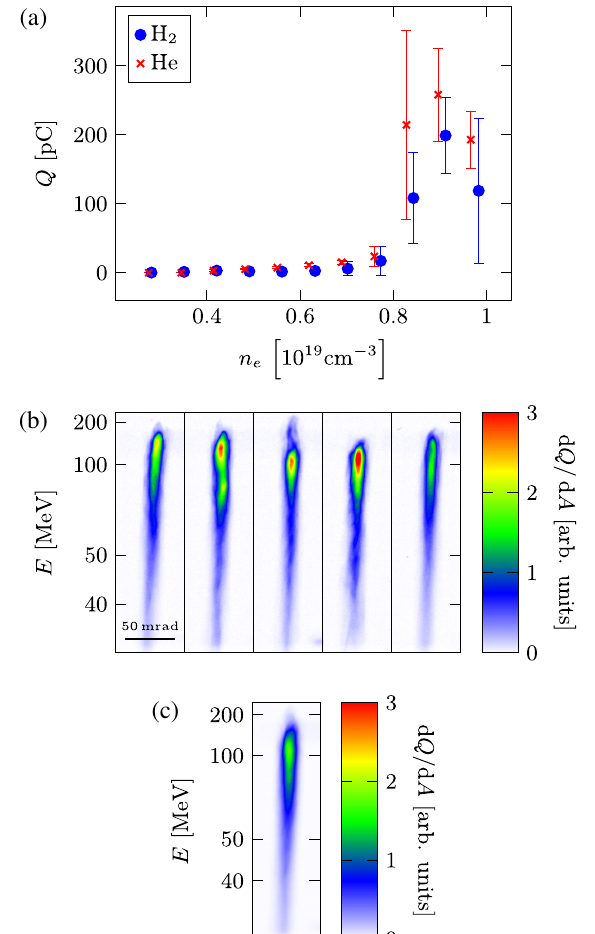
FIG. 4. (a) Measured charge Q from Fig. 2 plotted against plasma electron density n e (assuming full ionization) instead of backing pressure p 0 , by using the results of Fig. 3. Again, only electrons with energies exceeding the cutoff energy of the spectrometer setup contribute to Q . Each point represents the average of ten individual measurements with error bars indicating one standard deviation. (b) False-color images of five electron beams emerging from He at n e ¼ 9 . 8 × 10 18 cm − 3 dispersed by a permanent dipole magnet, showing a high resemblance to electron beams accelerated in H 2 at similar n e . (c) Average of the full ten-image sequence which is partly shown in (b). The color scales are normalized to the maximum signal in Fig.